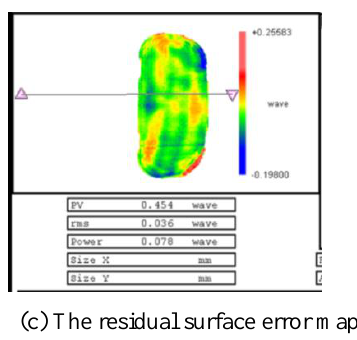
(c) The residual surface error map Fig. 3 Off-axis aspherical mirror is processed 7